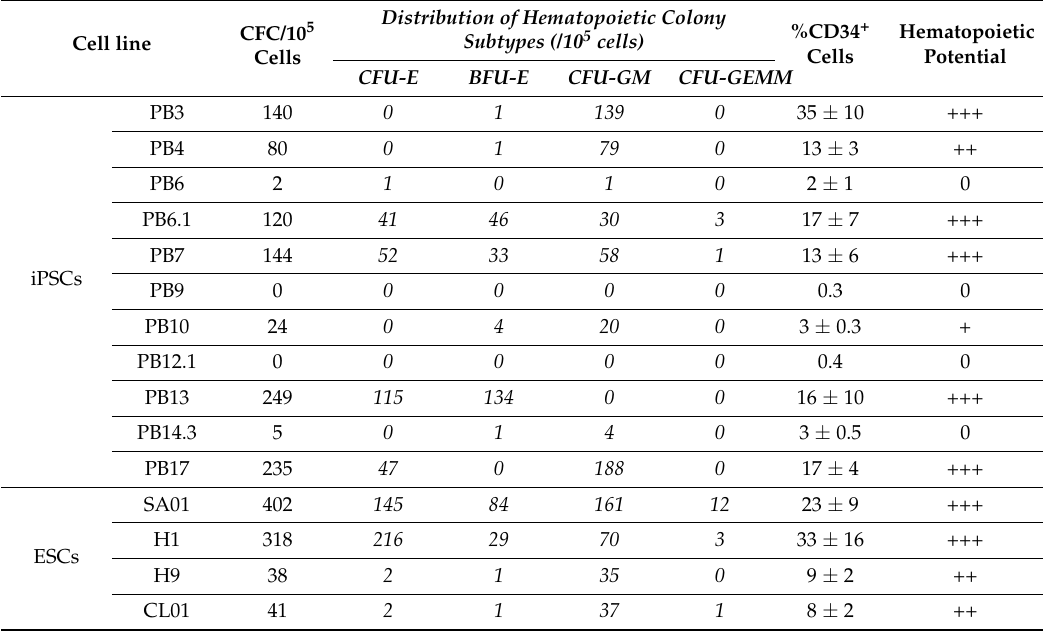
Table 2. Characterization of the hematopoietic potential of the hPSC lines used in this work. Distribution of Hematopoietic Colony + Hematopoietic CFC/10 5 Subtypes (/10 5 cells) %CD34 Cell line Potential Cells Cells CFU-E BFU-E CFU-GM CFU-GEMM PB3 140 0 1 139 0 35 ± 10 +++ PB4 80 0 1 79 0 13 ± 3 ++ PB6 2 1 0 1 0 2 ± 1 0 PB6.1 120 41 46 30 3 17 ± 7 +++ PB7 144 52 33 58 1 13 ± 6 +++ iPSCs PB9 0 0 0 0 0 0.3 0 PB10 24 0 4 20 0 3 ± 0.3 + PB12.1 0 0 0 0 0 0.4 0 PB13 249 115 134 0 0 16 ± 10 +++ PB14.3 5 0 1 4 0 3 ± 0.5 0 PB17 235 47 0 188 0 17 ± 4 +++ SA01 402 145 84 161 12 23 ± 9 +++ H1 318 216 29 70 3 33 ± 16 +++ ESCs H9 38 2 1 35 0 9 ± 2 ++ CL01 41 2 1 37 1 8 ± 2 ++ CFC, colony-forming cell; CFU-E, colony-forming unit-erythroid; BFU-E, burst-forming unit-erythroid; CFU-GM, colony-forming unit-granulocytes macrophages; CFU-GEMM, colony-forming unit-granulocytes erythrocytes macrophages megakaryocytes. Concerning hematopoietic potential, 0 represents iPS cell lines lacking hematopoietic differentiation ability, +/++ poor hematopoietic-competent hPSCs (less than 100 colonies/10 5 cells), +++ high hematopoietic-competent hPSCs (more than 120 colonies/10 5